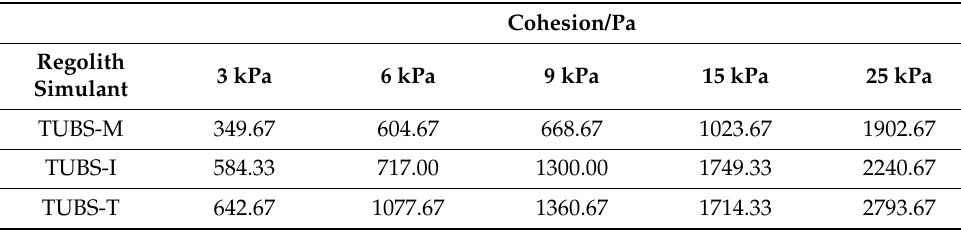
Table A3. Cohesion values of TUBS-M, TUBS-T, and TUBS-I at different shear